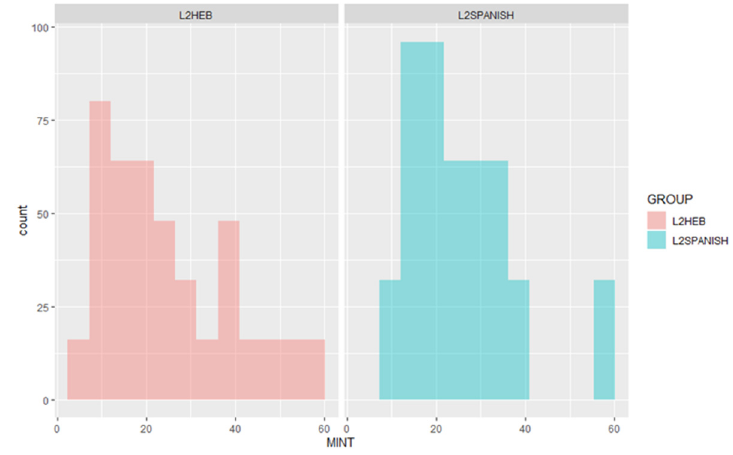
Figure 1. Variability in MINT scores by L2